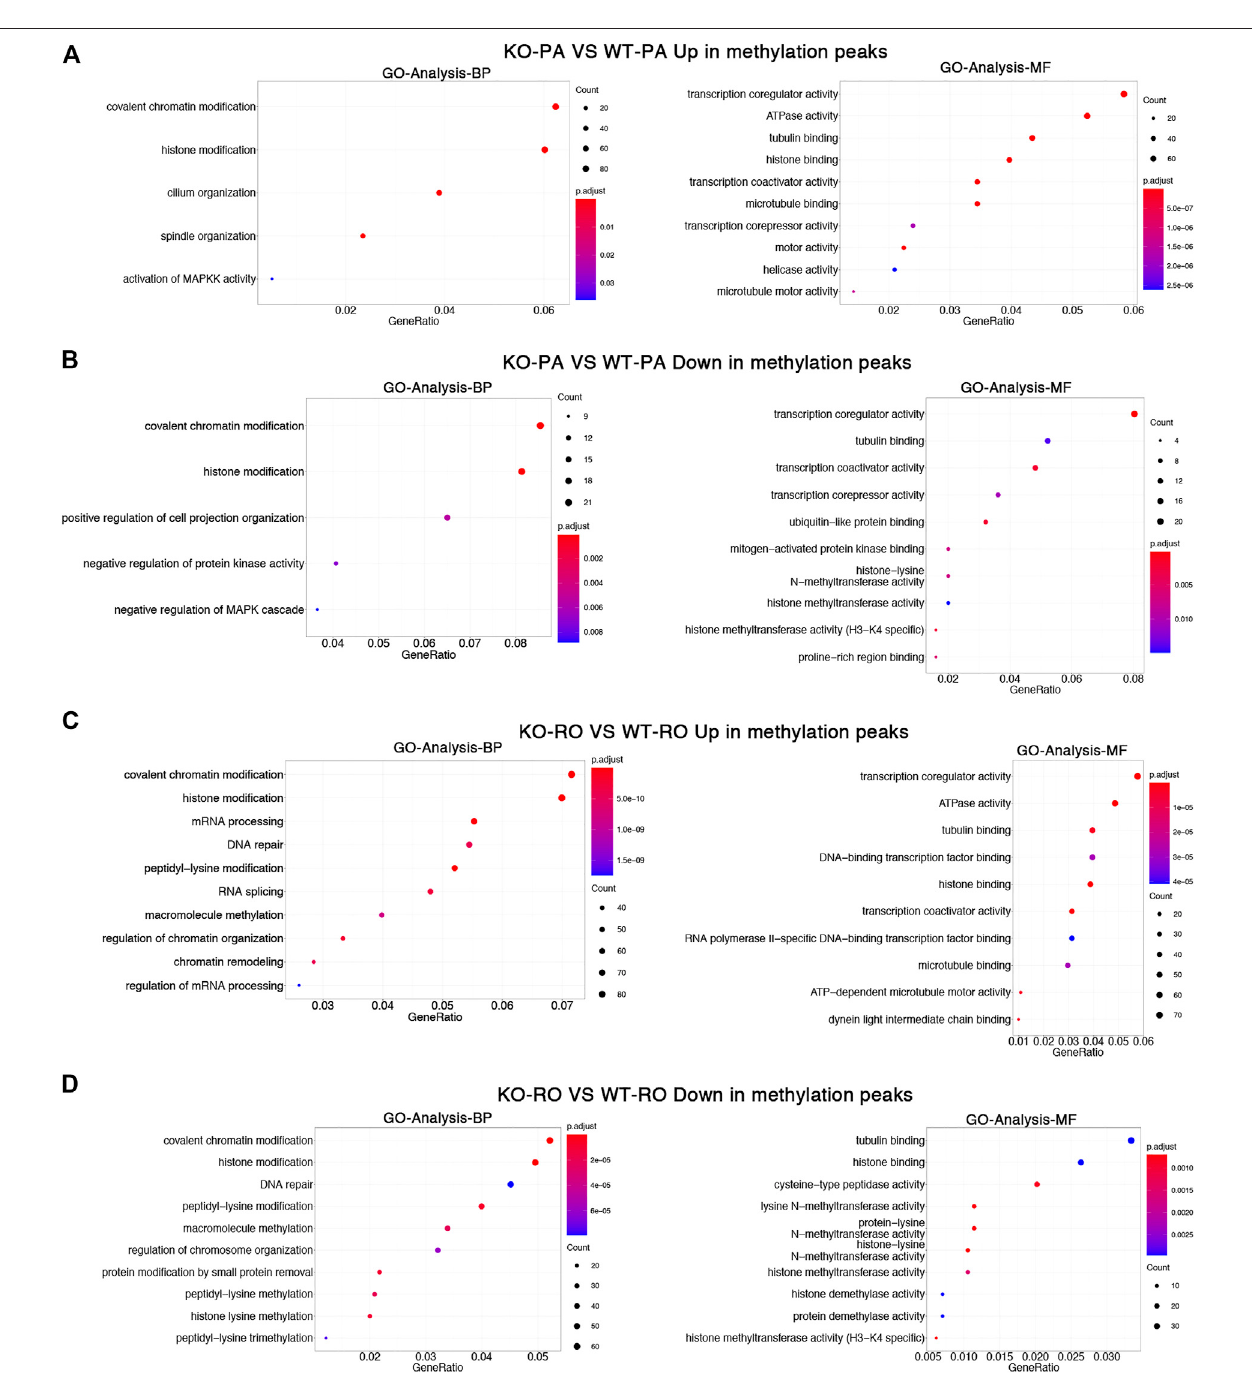
FIGURE3 | Differentially methylated mRNAs analysis. GO enrichmentanalysis ofupregulated (A) and downregulated (B) methylated mRNAs between Alkbh5 -KO PA and WT PA. GO enrichment analysis of upregulated (C) and downregulated (D) methylated mRNAs between Alkbh5 -KO RO and WT RO.